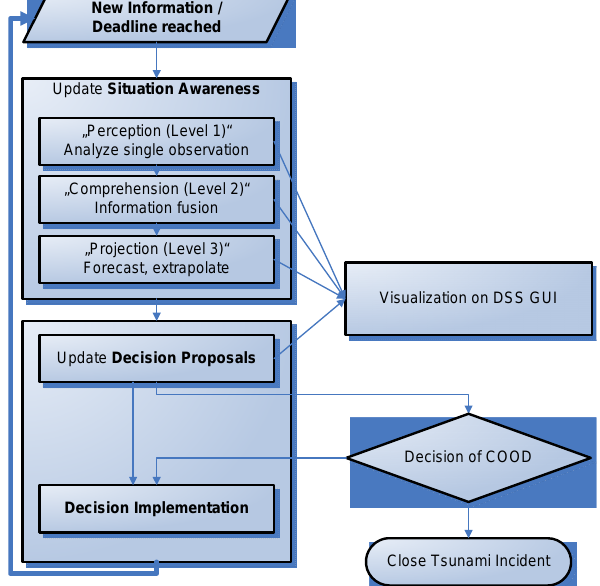
Fig. 2. The Decision Support Core Process. In Figure 2. The Decision Support Core Process. In Improving Situational Awareness, the system has to support the operator on the three subsequent levels of Perception, Comprehension and Projection before he will be able to decide and act given a warning configuration for the event at hand. The cycle is repeated every time new information becomes available.